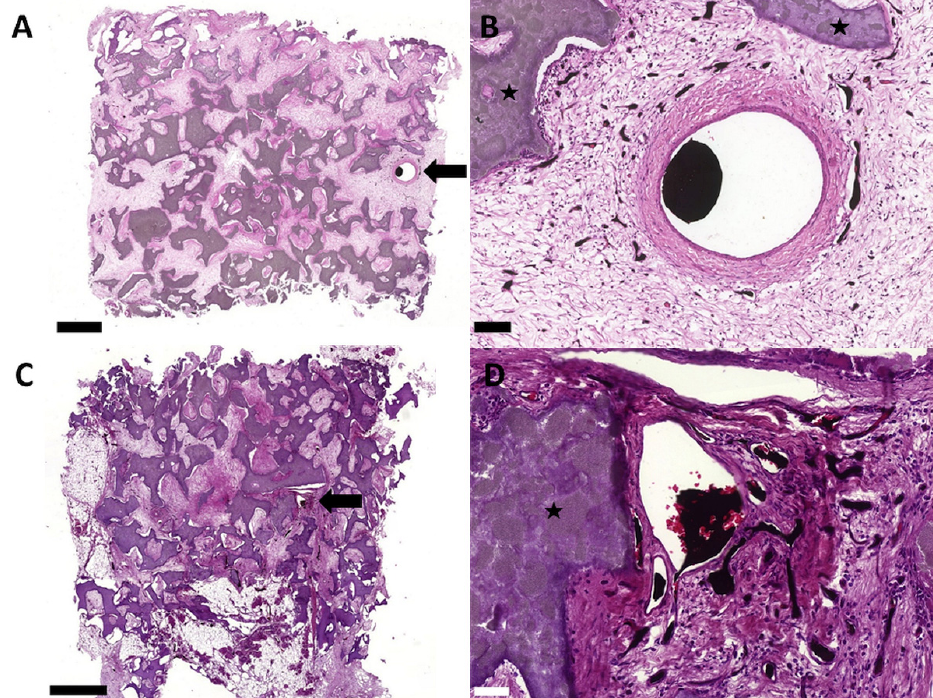
Figure 5. H&E staining with overview and detail images. The HA/ß–TCP granula were not com- pletely degraded. The fibrin gel was replaced by highly vascularized tissue ( B , D ). No bone formation was observed in the cell-free ( A , B ) or T17b EPC group ( C , D ). Bold bars indicate the AV loop and the black stars indicate the HA/ß–TCP granula. Scale bar = 1 mm ( A , C ), 100 µm ( B ) and 50 µm ( D ).